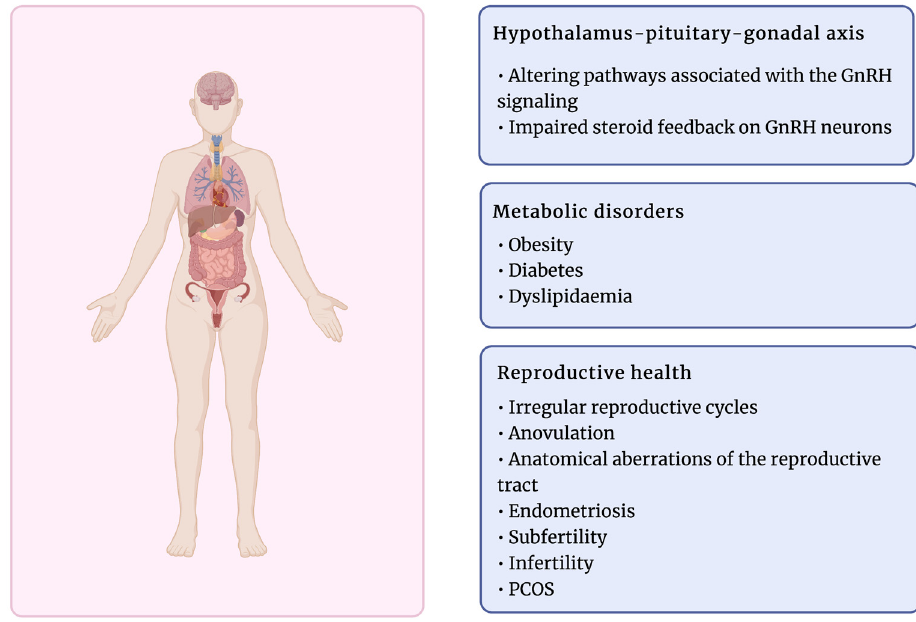
Figure 3. The effects of exposure to EDC on female health. Created with BioRender.com.